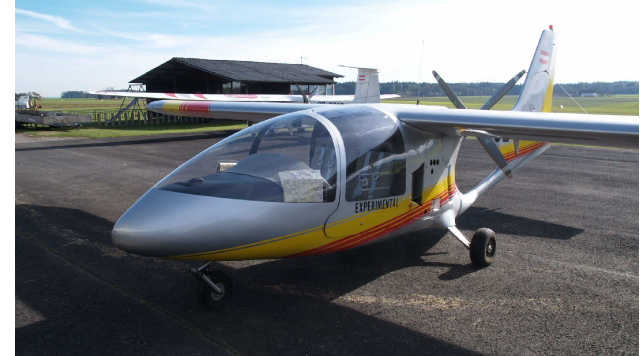
Figure 8: Experimental aircraft of the company Pauly Luftbild- fotographie. Camera and stabilizer was mounted outside in a carbon box